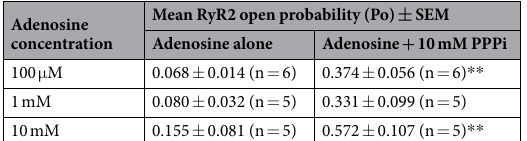
Table 1. Effect of adenosine on the ability of PPPi to activate RyR2. To avoid inaccuracies in the [adenosine] due to the limits of adenosine solubility, 1 and 10 mM adenosine were perfused into the cytosolic chamber following fusions of the SR vesicles and therefore it is not possible to determine a ‘control’ value in the absence of adenosine (although comparison with other channels at 10 µ M cytosolic Ca 2 + could be made). 100 μ M adenosine was obtained by addition of a 10 mM stock solution of adenosine, and in this case the control Po in the presence of 10 μ M Ca 2 + alone was 0.038 ± 0.009 (SEM, n = 6). Inactivation was not observed in any experiment but since adenosine binds reversibly to RyR2, one might expect to see occasional channel inactivation that occurred less frequently as the concentration of adenosine increased. However, this is difficult to show at the single-channel level and hence the [ 3 H]ryanodine binding data in Fig. 4A is likely to provide a more complete picture of overall RyR2 activities for populations of channel. Note that adenosine is a partial agonist at the RyR2 ATP site 29 . Adenosine alone does not increase Po above approx. 0.15, thus in the presence of an agonist with higher efficacy such as ATP or PPPi, it can appear to act as an antagonist. We have previously demonstrated that 100 μ M and 1 mM adenosine inhibit channel activation by 1 mM ATP by 57% and 74% respectively 29 . Therefore, unless PPPi and adenosine are both simultaneously aligned together in the ATP binding site (and the probability of this occurring will increase with increasing concentrations of adenosine), adenosine will appear to act as an antagonist. This is in line with the results since 10 mM adenosine and 10 mM PPPi gives the highest Po. (Mean values ± SEM are shown. ** p < 0.01. p values relative to adenosine alone).